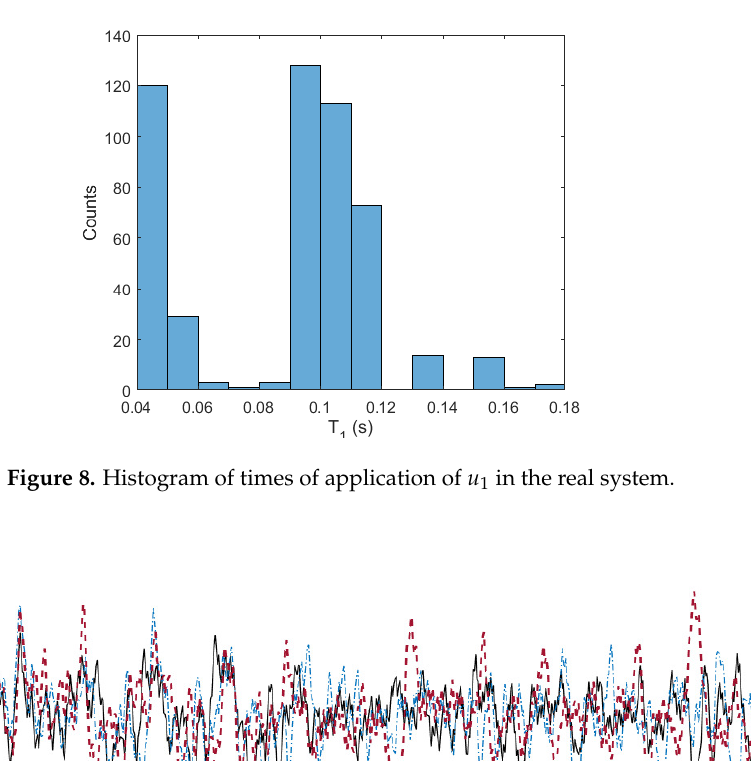
Figure 7. Input voltage applied to the air levitation system in the stabilization experiment. From top to bottom: the proposed algorithm, the algorithm in [30], and the auxiliary PI controller.